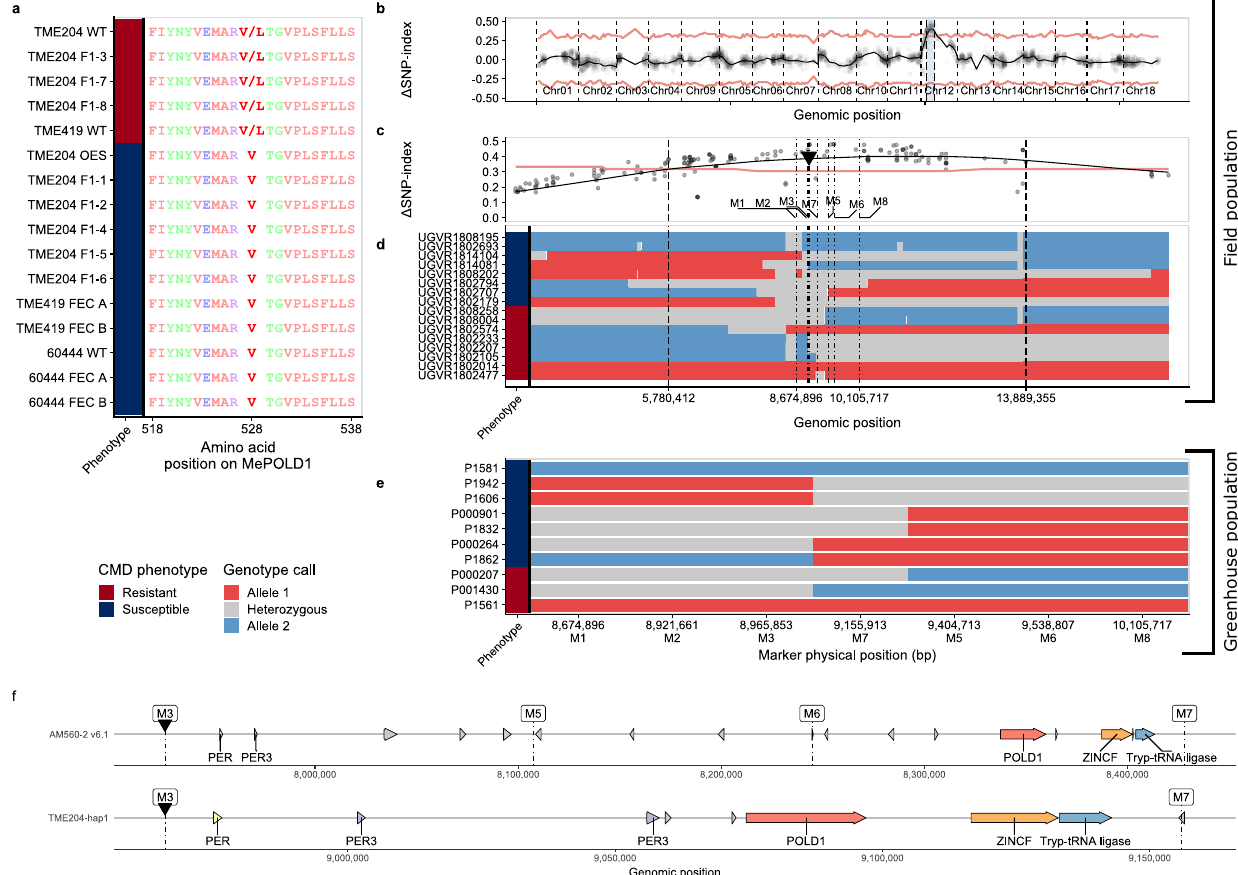
Fig. 2 Whole-genome sequencing and genome variant analysis (WGS-GVA) and fi ne mapping reveal nonsynonymous SNPs in MePOLD1 that segregate with resistance. a TME204-WT and F1 progeny, TME419-WT, 60444-WT and TME204, TME419 and 60444 plants regenerated from tissue culture (FEC) were tested for resistance and susceptibility. TME204 WT, F1-3, F1-7, F1-8, and TME419-WT plants had CMD2 resistance while all other plants were susceptible to ACMV infections. The resistance phenotype is indicated on the left bar (Red – Resistant; Blue – Susceptible). A haplotype 1- restricted G to C transversion in the TME204 MePOLD1 gene at location 9,081,215 bp causes a heterozygous V528L mutation in MePOLD1. Two large ( n ≈ 1000) F 1 mapping populations derived from NASE14×TME204-LCR were used to fi ne-map CMD2 ( b – e ). b An in silico bulk segregant approach was performed using the fi eld phenotyping and genotyping by sequencing (GBS) data (Fig. 1c). The tricube-smoothed allele frequency enrichment ( Δ SNP- index) across the TME204-hap1 assembly. In ( c ) and ( d ) the red line denotes the 95% con fi dence interval. The highlighted region on Chr12 de fi nes the signi fi cantly linked CMD2 region. c Enlargement of the CMD2 locus mapping results. Each point represents a SNP and its corresponding Δ SNP-index. The dashed lines indicate the borders of the mapped locus between ~5 – 13 Mb. The previously reported associated marker from Rabbi et al. is indicated by black arrow 9 . d Examining the GBS SNP data from individual recombinants within the locus improves the mapping resolution to ~300 kb. Genotypes are extended downstream until the next SNP called. Two non-recombinant homozygous resistant and susceptible lines are added as a control (top and bottom). Based on the location of the mapped locus, and the previously identi fi ed GWAS marker, KASP markers (M1-8) were developed for fi ne mapping (positions denoted by dot-dash lines in ( c ) and ( d ). e A second fi ne-mapping population was phenotyped in the greenhouse using a virus-induced gene silencing- based infection assay. Recombinants within the region place CMD2 in the 190Kb interval between markers M3 and M7. Lines P1581 and P1561 are non- recombinant susceptible and resistant controls, respectively. In ( c ) and ( e ) the genotype at each SNP or marker is indicated by the colour (Allele 1, Red, linked to Resistance; Allele 2, Blue, linked to Susceptibility). The resistance phenotype is indicated on the left bar as above. f Genomic rearrangements within the fi ne-mapped CMD2 locus introduce new gene